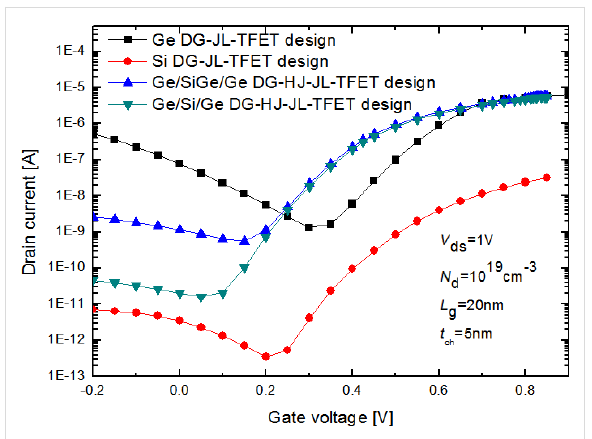
Figure 2: Drain current as a function of the applied gate voltage for the DG-HJ-JL TFET proposed with different heterochannel configurations compared to that of the conventional homochannel designs ( L g = 20 nm, L s = 10 nm and N d = 1·10 19 cm − 3 , t ch = 5 nm and V ds = 1